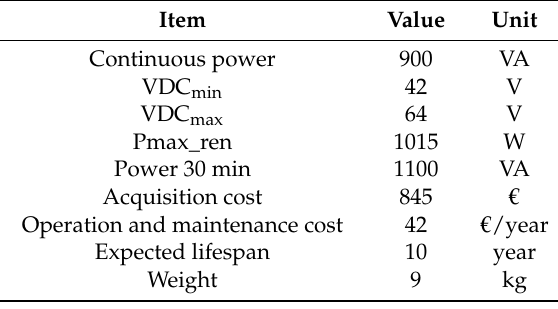
Figure 4. Diagram of inverter efficiency [30].